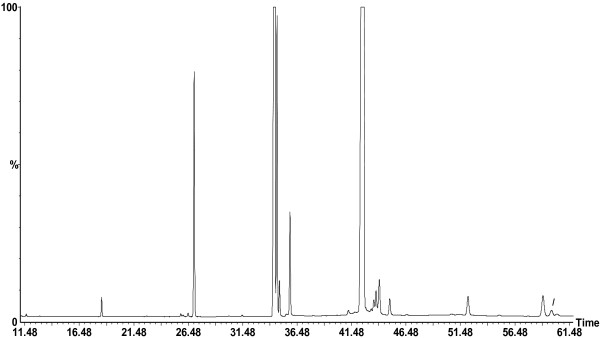
GC-MS chromatogram of FAMEs in the TLs of Calendula officinalis L. (CO2: cv. Prolifera nr. 214) seeds analysed with a BPx- 70 capillary column. Peaks: (1) lauric (12:0), (2) myristic (14:0), (3) pentadecanoic (15:0), (4) cis-7 hexadecenoic [16:1 (n-9)], (5) palmitoleic [16:1 (n-7)], (6) palmitic (16:0), (7) margaric (17:0), (8) linoleic [18:2 (n-6)], (9) oleic [18:1 (n-9)], (10) elaidic [18:1 (9 t) (n-9)], (11) linoelaidicic [18:2 (9 t,12 t) (n-6)], (12) stearic (18:0), (13) α- linolenic [18:3 (n-3)], (14) calendic [18:3 (8 t, 10 t, 12c) (n-6)], (15) gondoic [20:1 (n-9)], (16) β- calendic [18:3 (8 t, 10 t, 12 t) (n-6)], (17) arachidic (20:0), (18) 9- hydroxy- trans-10, cis-12 octadecadienic (9- HODE), (19) behenic (22:0) acids.